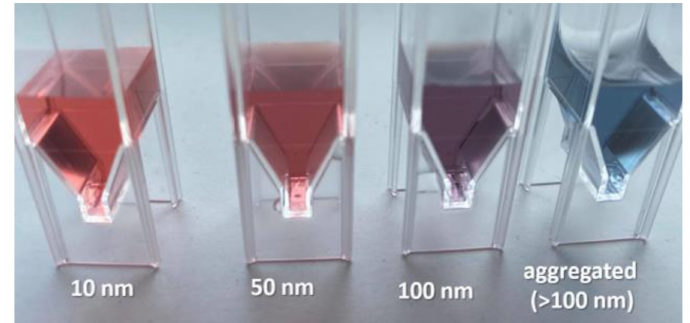
Figure 2. Color changes of AuNPs depending on their